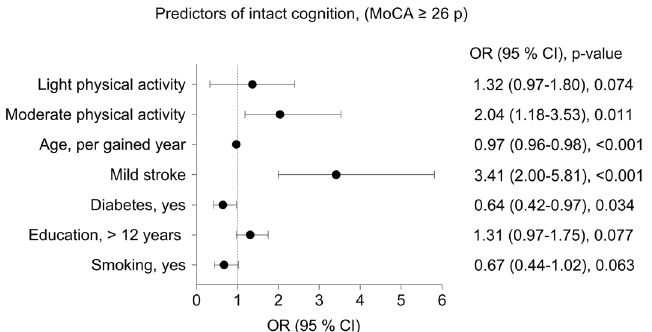
Figure 3. Associations of prognostic factors for intact cognition presented with Forest plots. Associations are presented as values for odds ratio (OR) and 95% confidence interval (95% CI). Intact cognition was defined as a score of ≥ 26 points on the Montreal Cognitive Assessment (MoCA 0–30), physical activity on the Saltin-Grimby Physical Activity 4-Level Scale (SGPALS), and stroke severity according to the National Institutes of Health Stroke Scale (NIHSS 0–42) as mild (0–5 points) or moderate (6–14